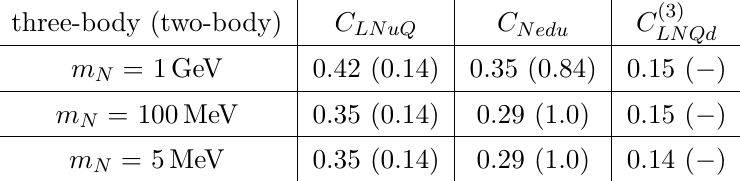
Table 4 . 1 σ upper bounds on the ¯ N production operators from measurements of the inclusive decays, B → ‘ +